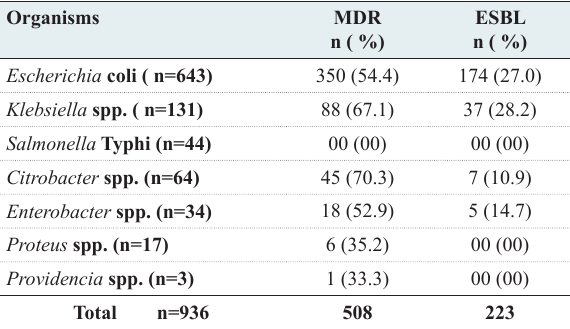
Table 2: The rate of ESBL production and MDR among the Enterobacteriaceae